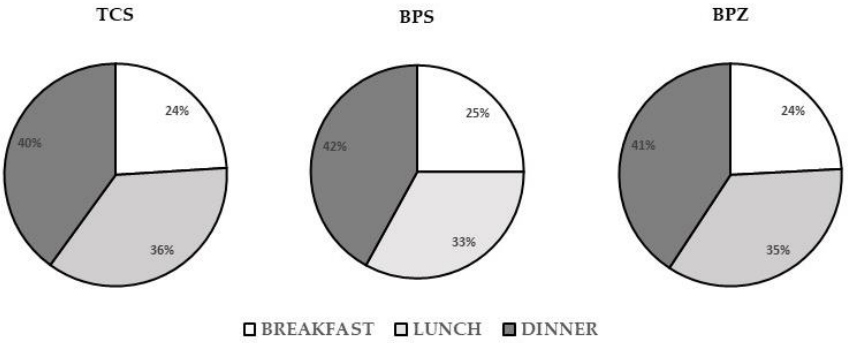
Figure 1. Percentage of DDSF samples with detectable levels of TCS, BPS, and BPZ residues by sampling time period 1 (breakfast = 4:00–11:00 a.m.), period 2 (lunch = 11:00 a.m.–5:00 p.m.), and period 3 (dinner = 5:00 p.m.–4:00 a.m.).